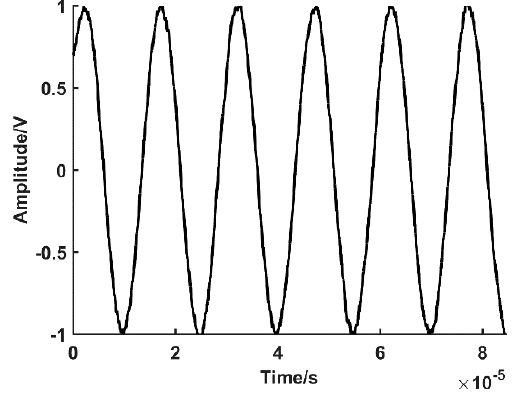
Figure 6. Sinusoidal signal with noise elimination by zero phase bandpass filter.